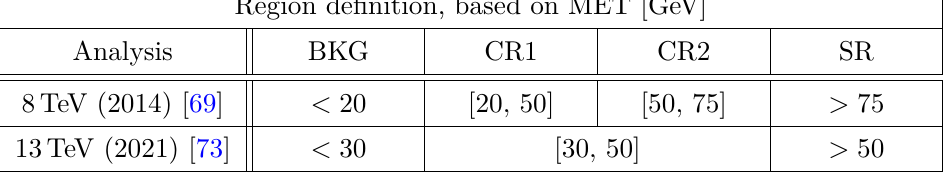
and background modelling. Within the signal region, the calculation of | ∆ z carried out only with the photon with the maximum t